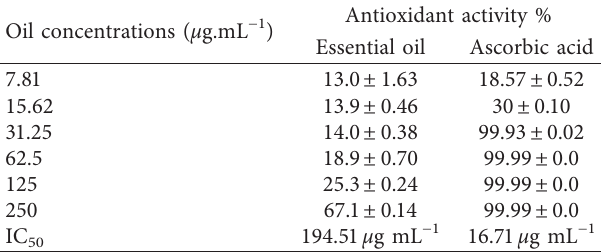
Table 4: Mean and standard deviation of the percentage of anti- oxidant activity of T. procumbens essential oil in different